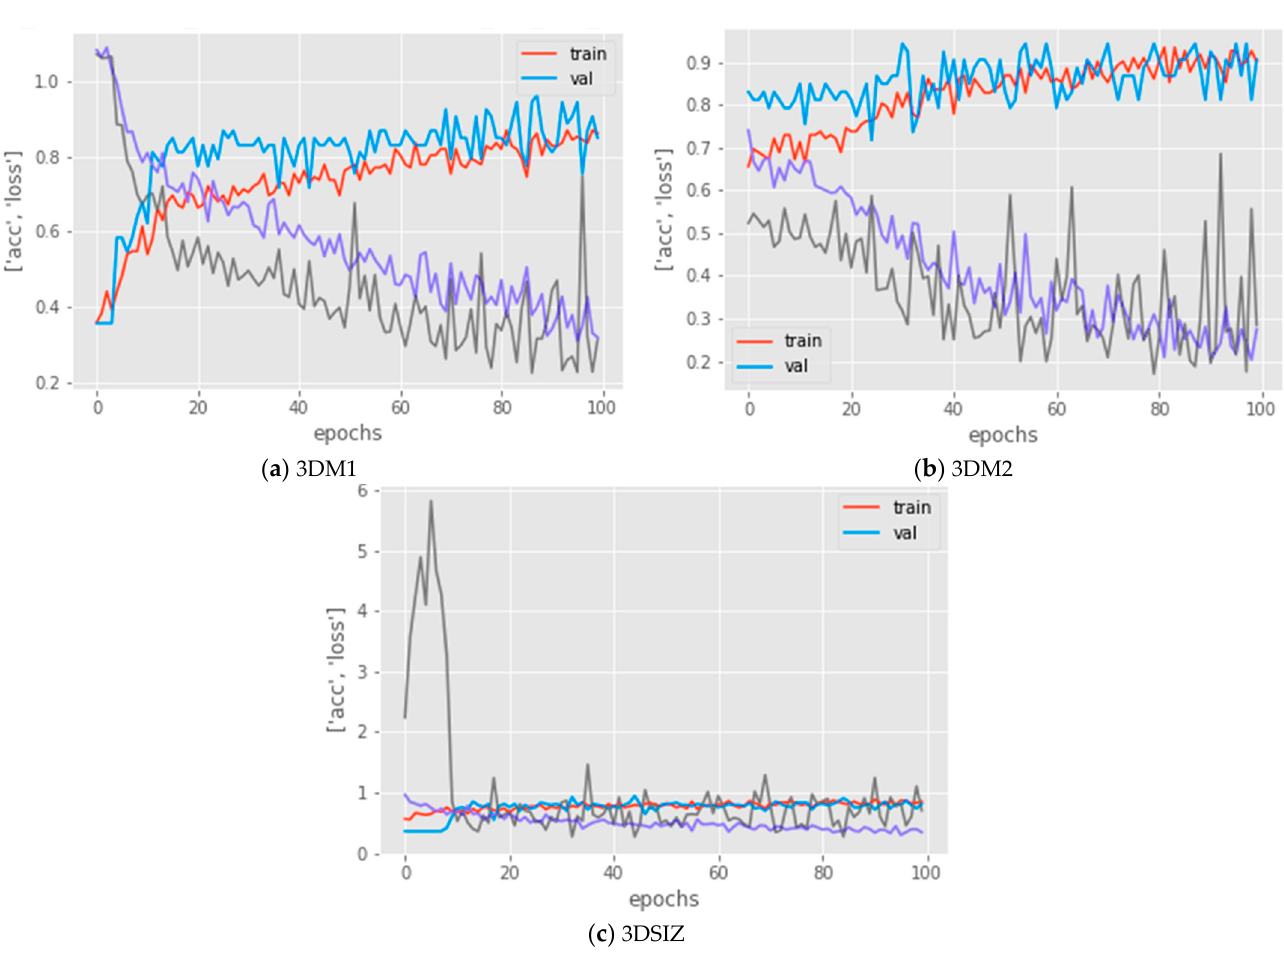
Figure 4. Learning curves that show the accuracy and loss of the training dataset (colored red and gray, respectively) against the accuracy and loss of the validation dataset (colored blue and purple, respectively) for the three models: 3DM1, 3DM2, and 3DSIZ.